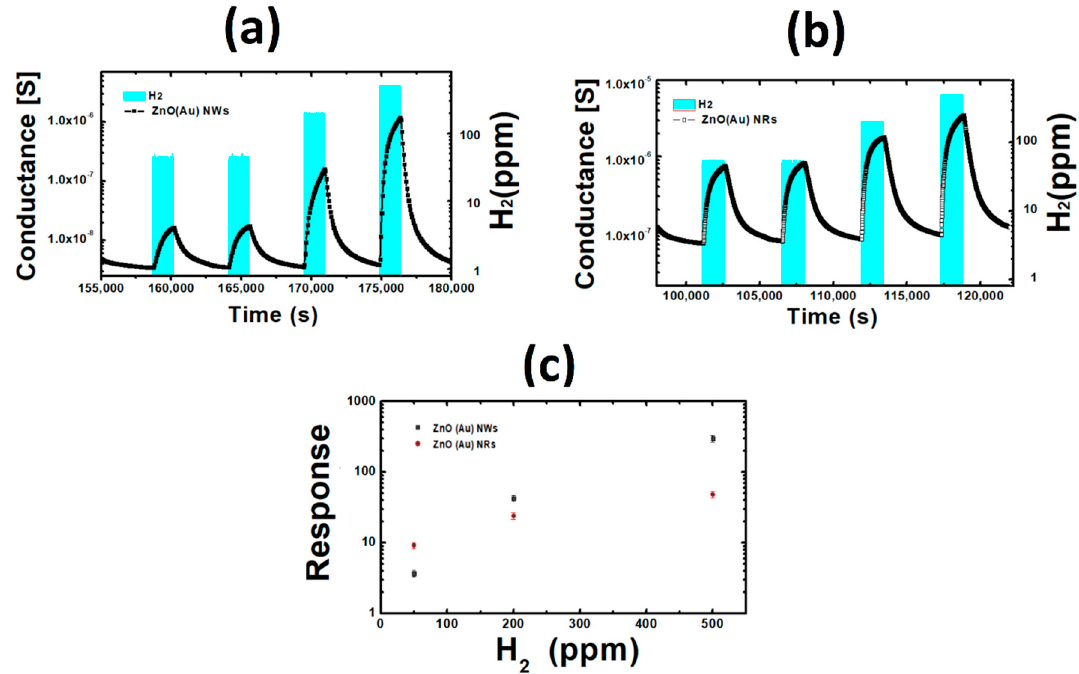
Figure 9. ( a ) Dynamic response ZnO NWs at 350 °C; ( b ) Dynamic response of ZnO NRs at 350 °C; ( c ) Calibration curves.